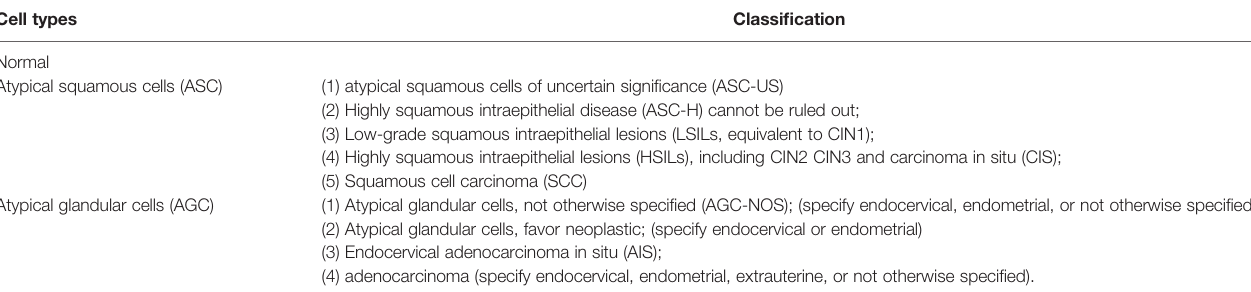
TABLE 1 | The Bethesda